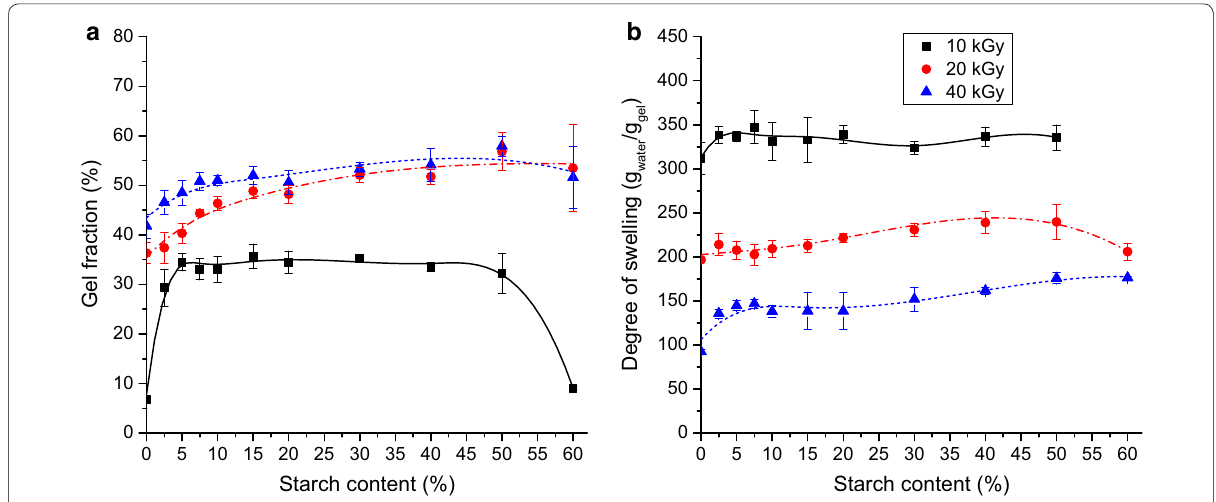
Fig. 1 The effect of starch content on the gel fraction ( a ) and on the degree of swelling ( b ) of CMC/starch hydrogels (20 w/w% solution, absorbed doses: 10, 20 or 40